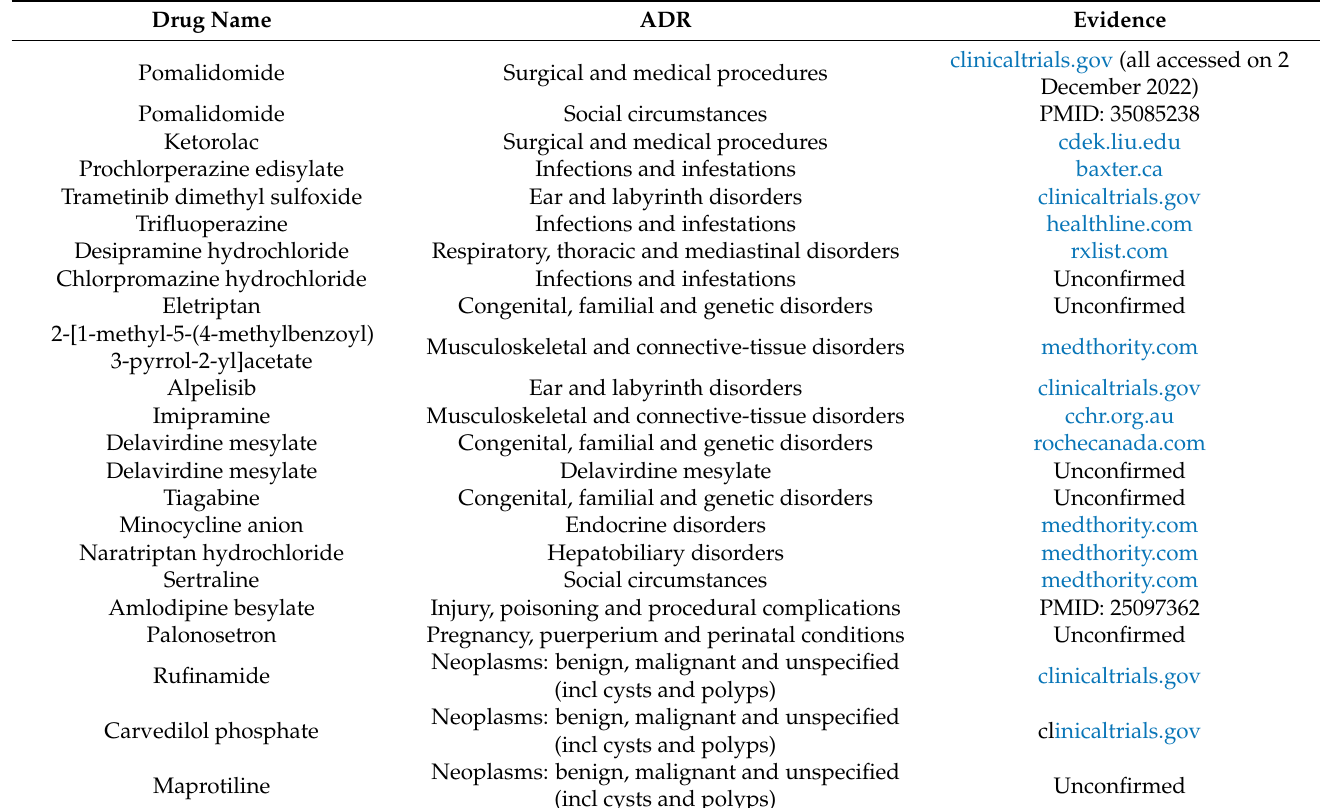
Table 3. Potential